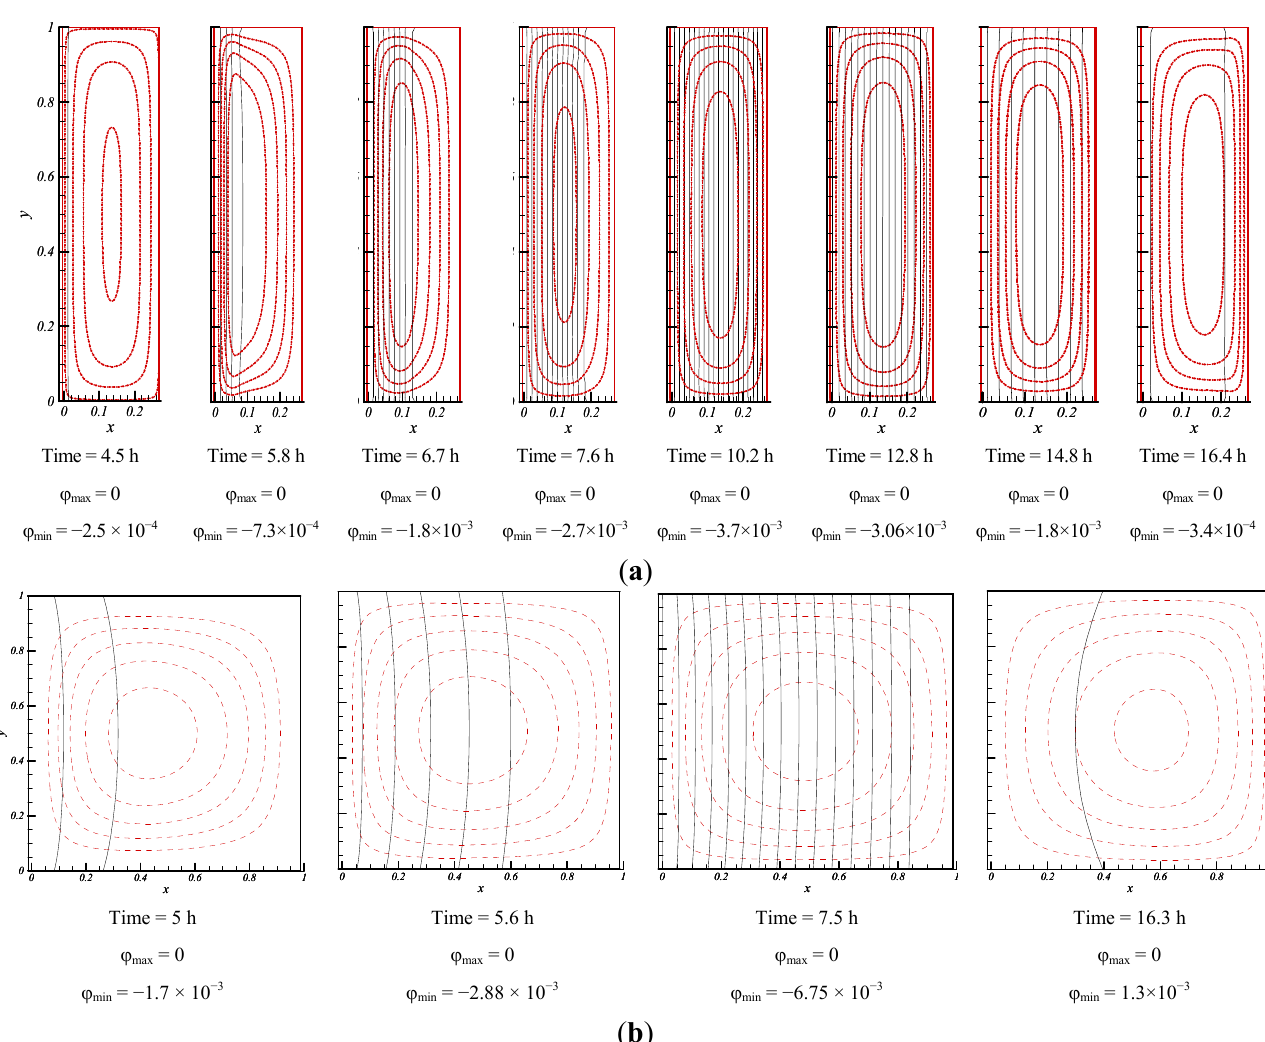
Figure 2. Streamlines (red) and isotherms (black) in the MEPCM layer. ( a ) A = 26 o C) and ( b ) A ( T M